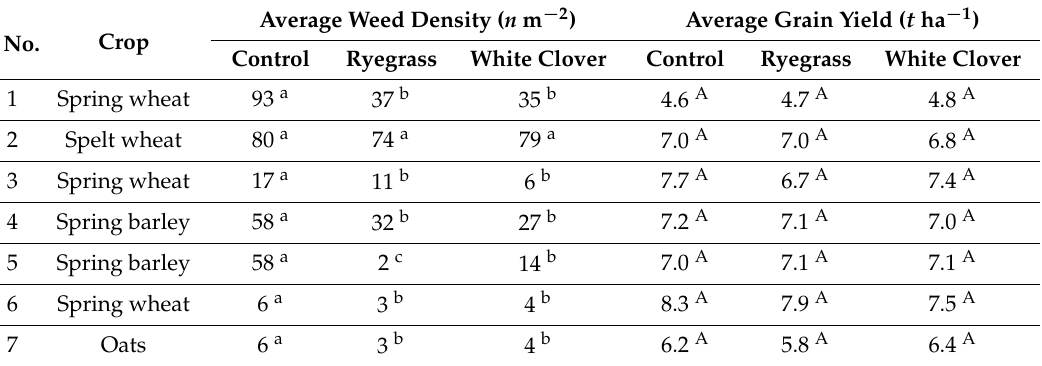
Table 2. Average weed densities ( n m − 2 ) and average grain yields ( t ha − 1 ) of the seven field experiments after early sowing of living mulch; Tukey-tests at a significance level of α ≤ 0.05 were performed for each single experiment; means with identical letters within each experiment do not differ significantly based on the Tukey-HSD test ( p < 0.05).